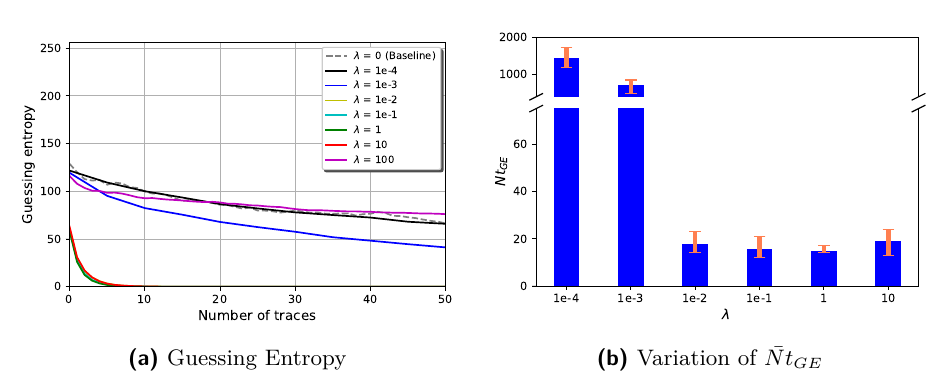
Figure 15: Attacking results of different λ (average over 20 fine-tuned models).